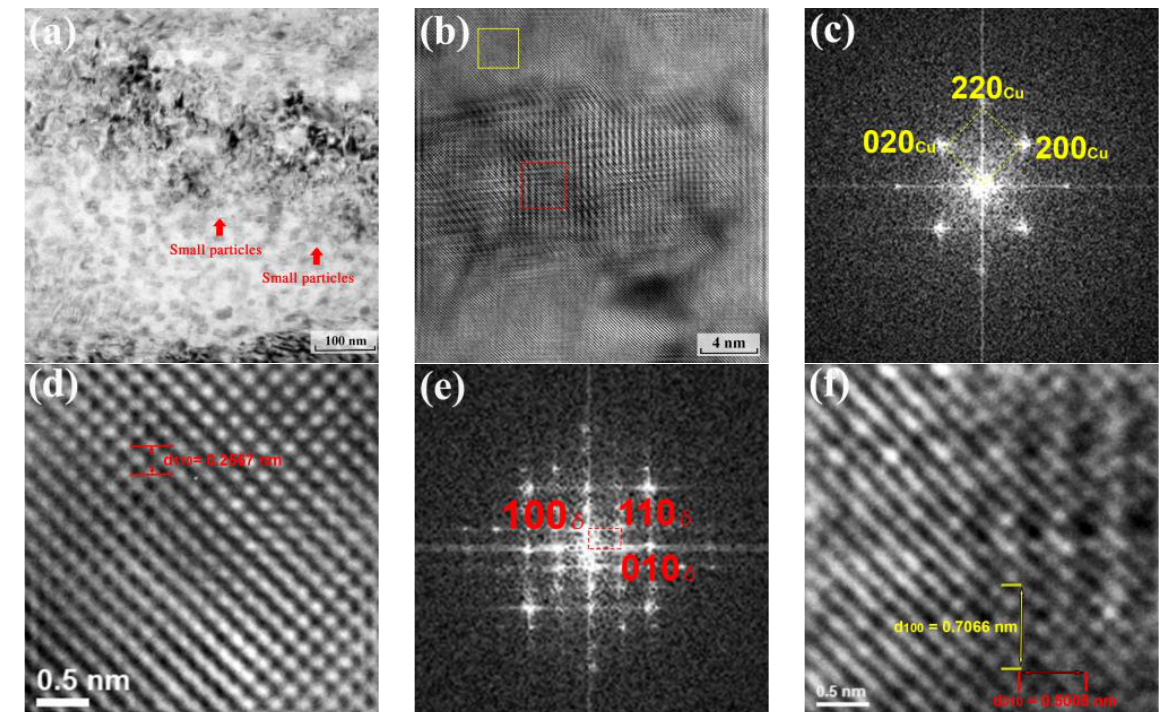
Figure 3. ( a ) TEM images of Cu 86.5 alloy aged at 500 °C for 1 h bright field image through [100] Cu , ( b ) HRTEM image through [100] Cu , ( c ) SAED pattern of FCC Cu-rich matrix, ( d ) Lattice image of FCC Cu-rich matrix through [100] Cu , ( e ) SAED pattern of δ -Ni 2 Si, and ( f ) Lattice image of δ -Ni 2 Si through [100] Cu.